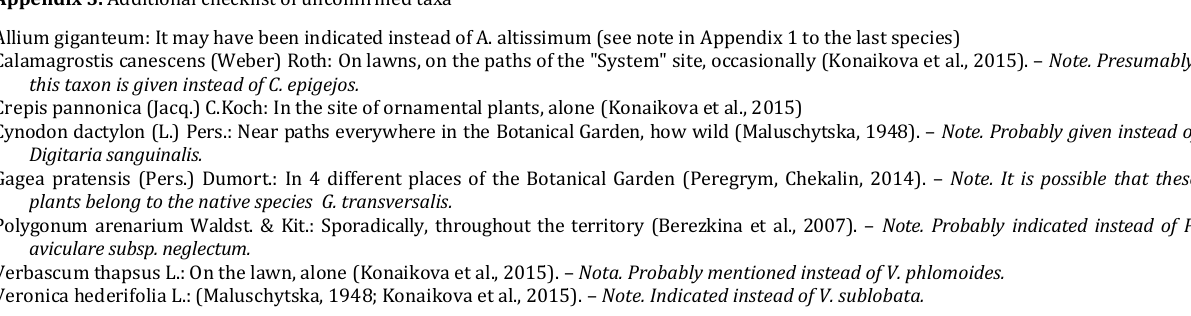
Fig. 2. Allium altissimum Fig. 3. Apocynum cannabinum Fig. 4. Coreopsis grandiflora